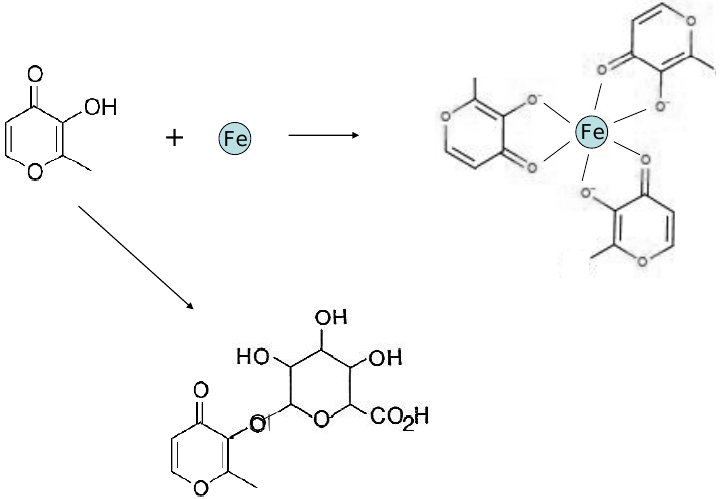
Figure 3. The formation of the tris-maltol iron (III) complex and maltol glucuronide. At physiological pH, maltol reacts with iron (III), forming the tris-maltol iron octahedral complex with iron in the centre. During iron (III) binding, a proton is displaced from the hydroxyl group of each maltol molecule, forming a negatively charged molecule, which coordinates with iron (III) of 3+ charge, forming a neutral trimaltol iron (III) complex. In humans, maltol is mostly metabolised to the maltol glucuronide conjugate, which has no iron or other metal chelating capacity. The in vitro screening procedure of the chelators involved the study and characteri- sation of iron complex formation, the interaction with proteins of iron metabolism, and the iron transport effects in red blood cells (RBC), as well as the iron transport effects in rat jejunum permeation [25,57].